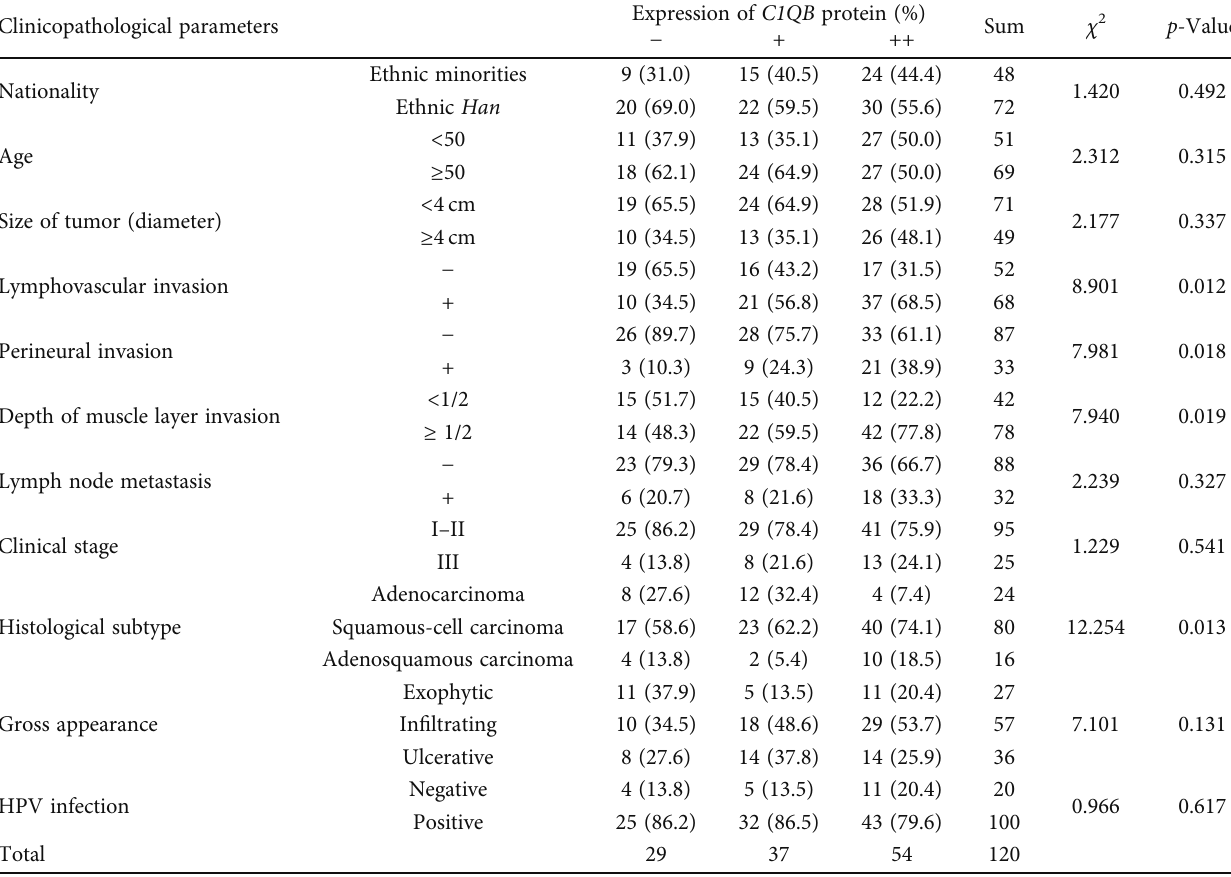
Table 2: Expression of C1QB protein in di ff erent groups of clinicopathological parameters in cervical cancer. Clinicopathological parameters